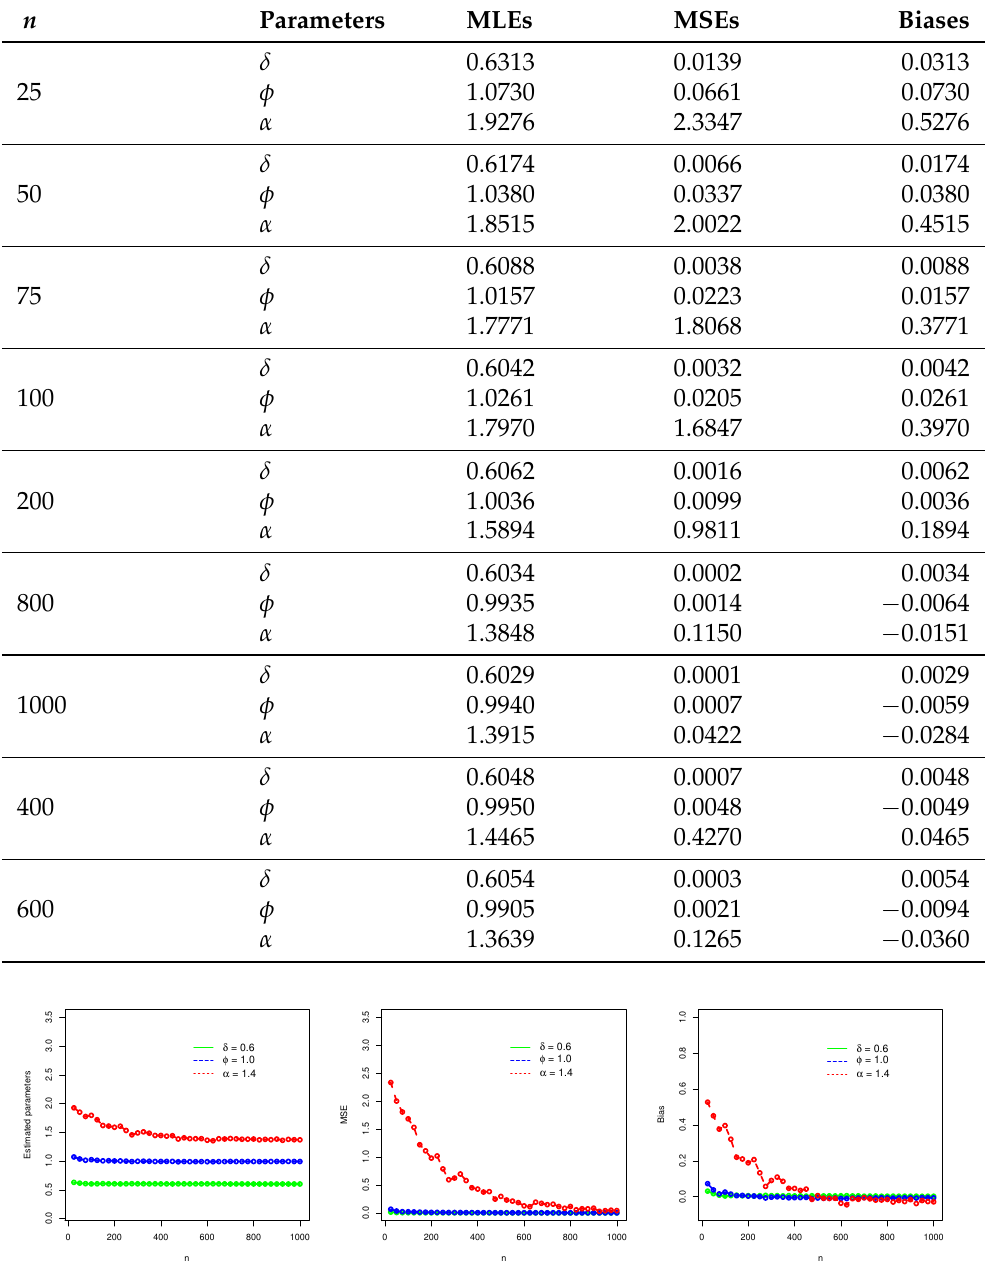
Table 2. The numerical illustration of the SS of the NACos-Weibull distribution for δ = 0.6, φ = 1.0, and α = 1.4.